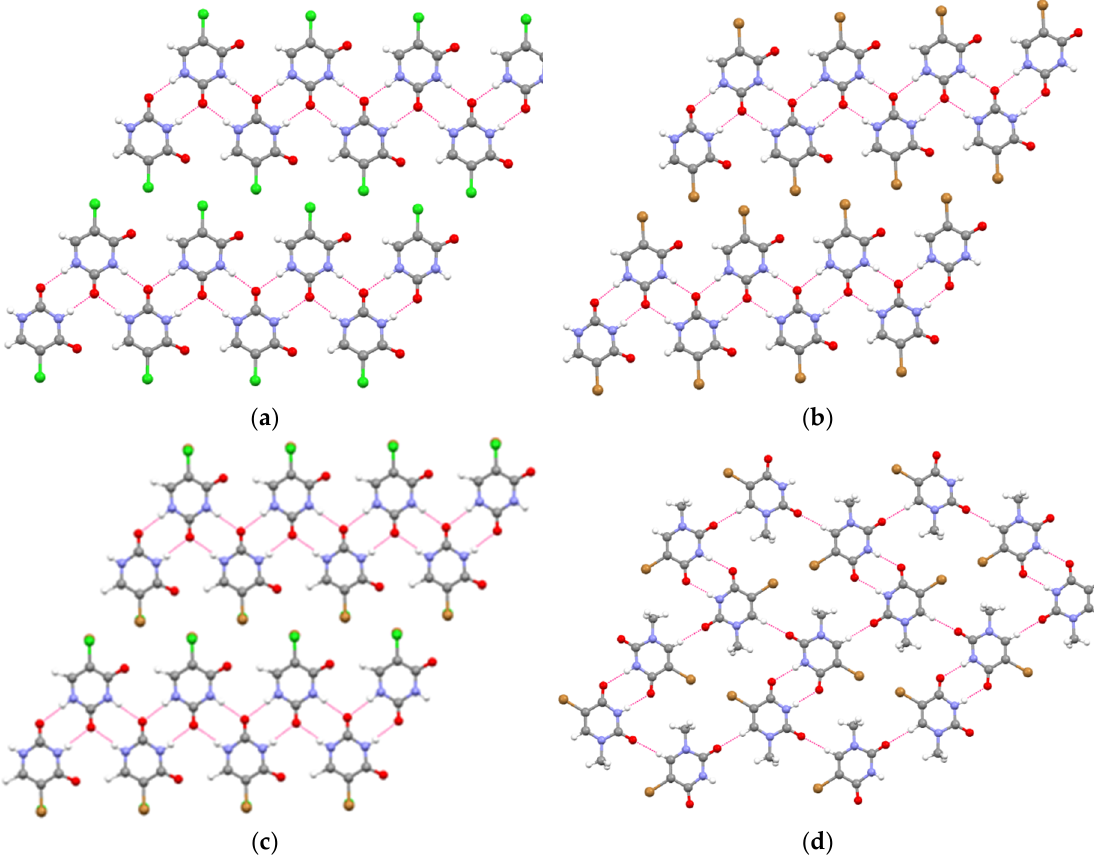
Figure 1. Hydrogen bonding in the crystal packing of 5-halouracils. ( a ) 5Clura. ( b ) 5Brura. ( c ) 5Cl5Brura. ( d ) 5Br1Mura. For the sake of clarity, in ( a , b ) only one of the two sites of the disordered 5Clura and 5Brura molecules is shown. Hydrogen bonds are shown as red dotted